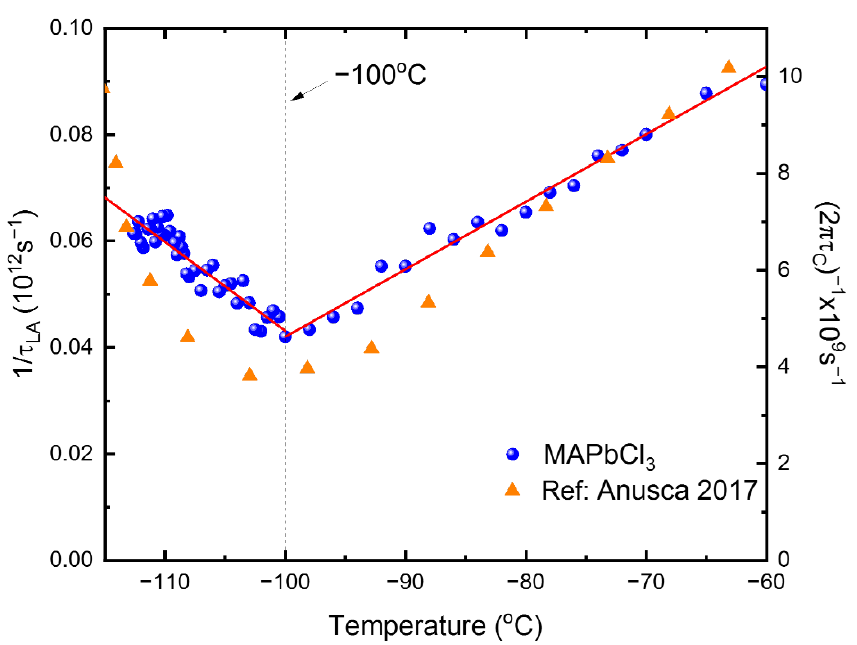
Figure 9. (Color online). Temperature dependence of the inverse relaxation time obtained by using the acoustic anomalies of the LA mode and Equation (3) [20]. The solid line is the best-fitted result by using Equation (4). The inverse dielectric relaxation time τ c taken from [23] is shown for compar- ison.